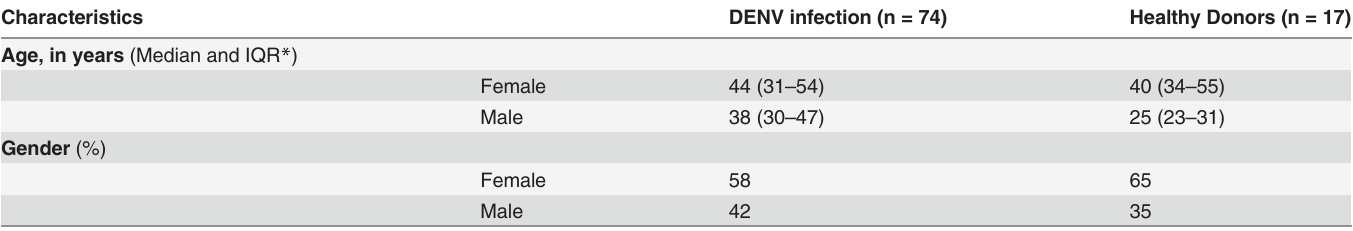
Table 1. Demographic characteristics of dengue patients and healthy donors.